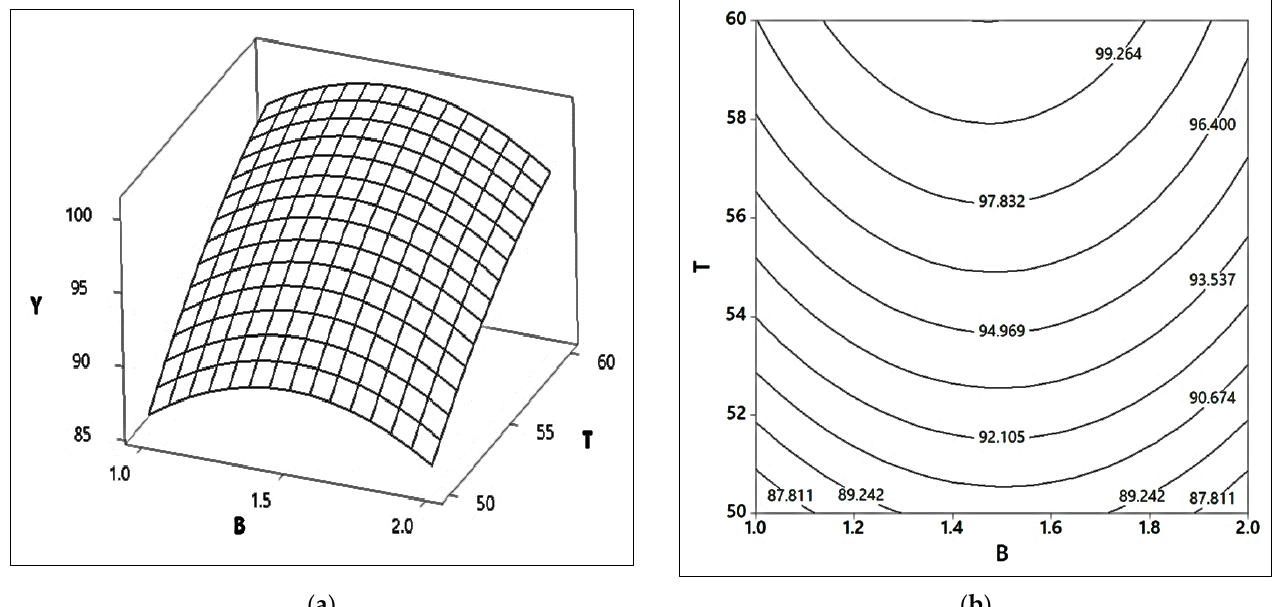
Figure 17. Interaction effect of the reaction temperature (T) and catalyst content (B) on the FAME yield (Y) of the transesterification process. ( a ) A 3D response surface plot of Y (%) vs. T (°C) and B (wt.%). ( b ) A 2D contour plot between T (°C) and B (wt.%).